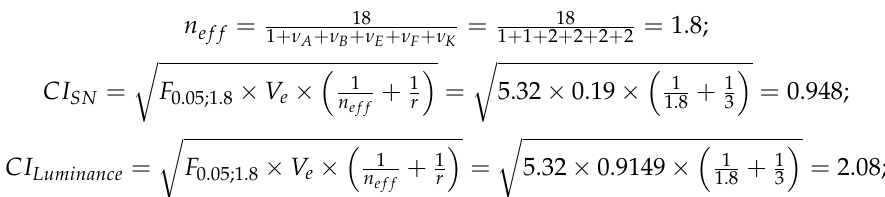
Table 14. Results of the confirmation experiments for the Taguchi Method. EXP.